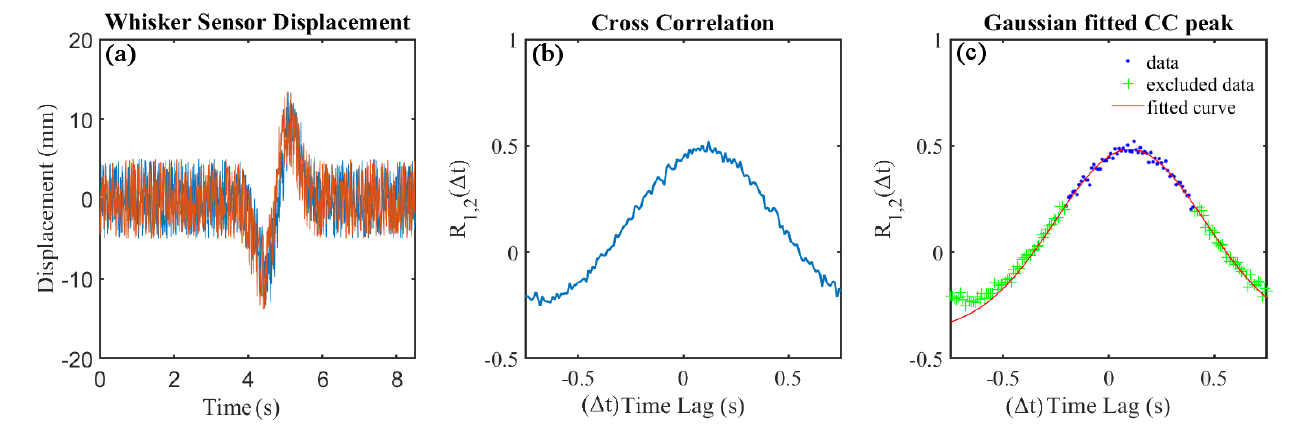
Figure 7. Synthetic jerk-pulse with added random noise and its CC profile. ( a ) jerk signal with an SNR of 2.6 in original (red) and time-shifted with 0.1 s (blue), noise addition is random and independent in both signals. ( b ) CC of the noisy signals, showing erratic fluctuations near the peak. ( c ) Gaussian curve fit in the peak region with a clear maximum at the expected